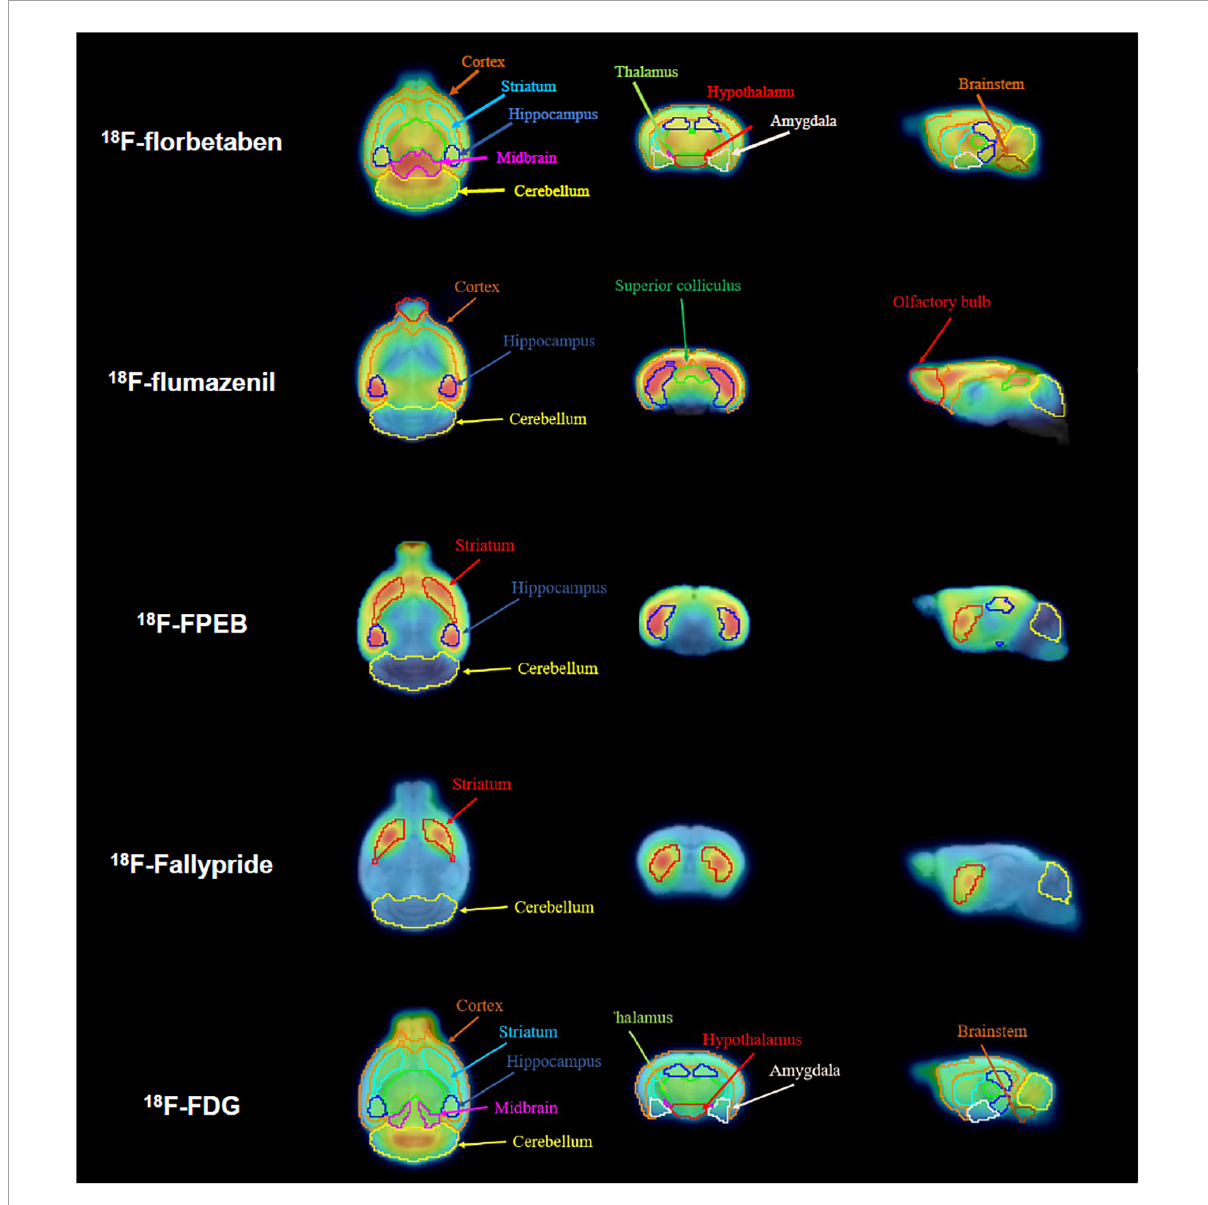
FIGURE1 Definition of volumes of interest (VOIs) for all positron emission tomography (PET) tracers. Magnetic resonance (MR) images for the horizontal, coronal, and sagittal planes are presented. Spatially normalized PET images were applied to the VOIs for each radiotracer.